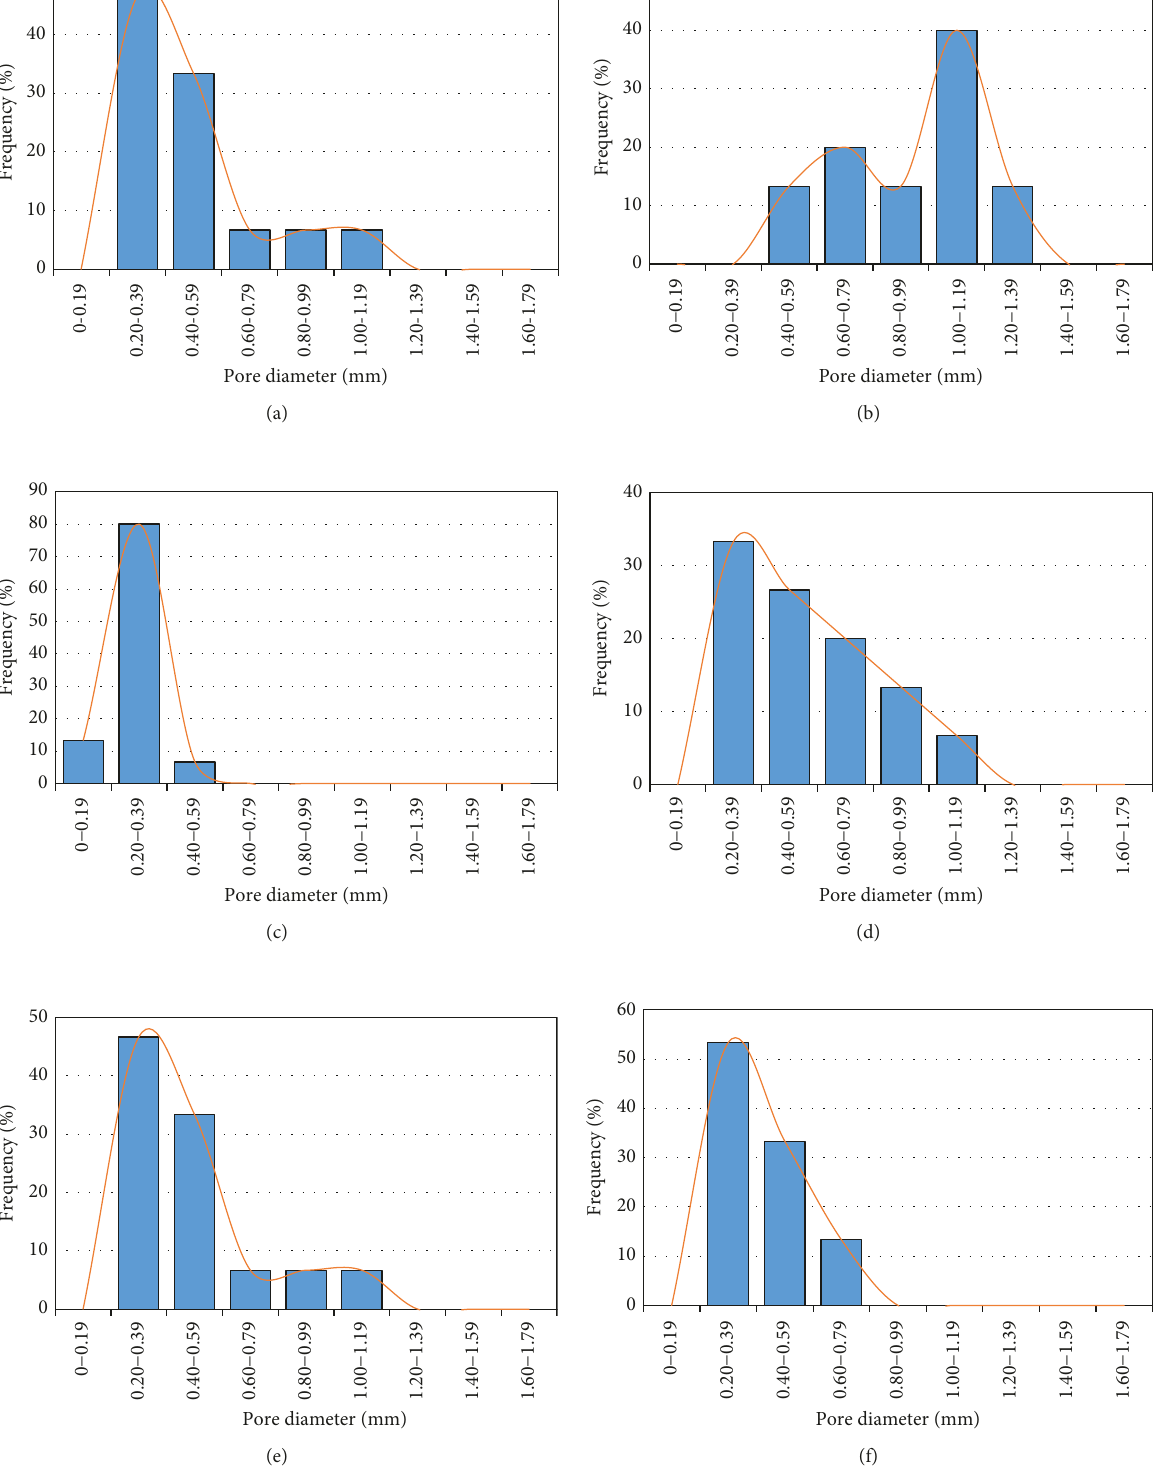
1.2, Si 0.085%); (c) exp. 8 (R/Al (cid:31) (cid:31) 0.8, Si 0.150% (cid:31) (cid:31)